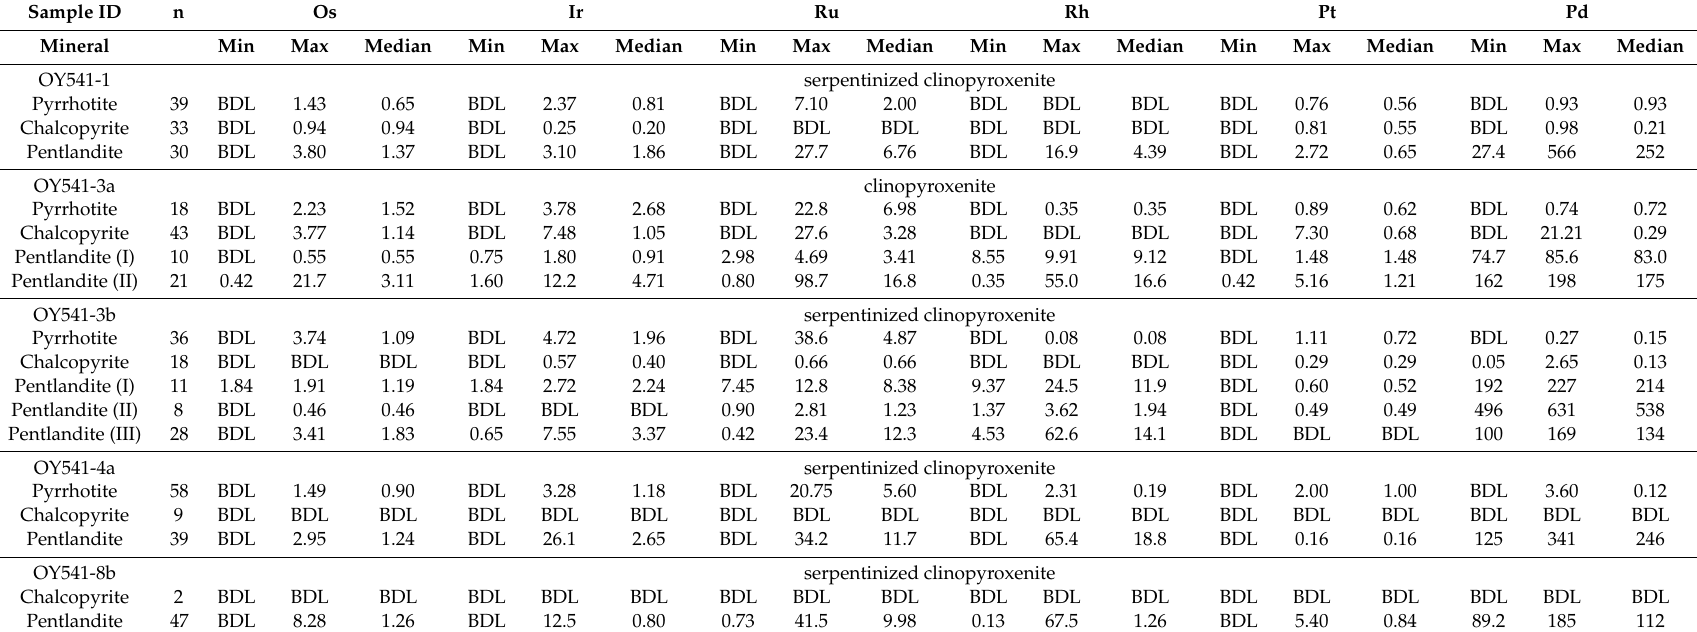
Table 5. Minimum, maximum and median PGE concentrations (in ppm) in the BMS (from